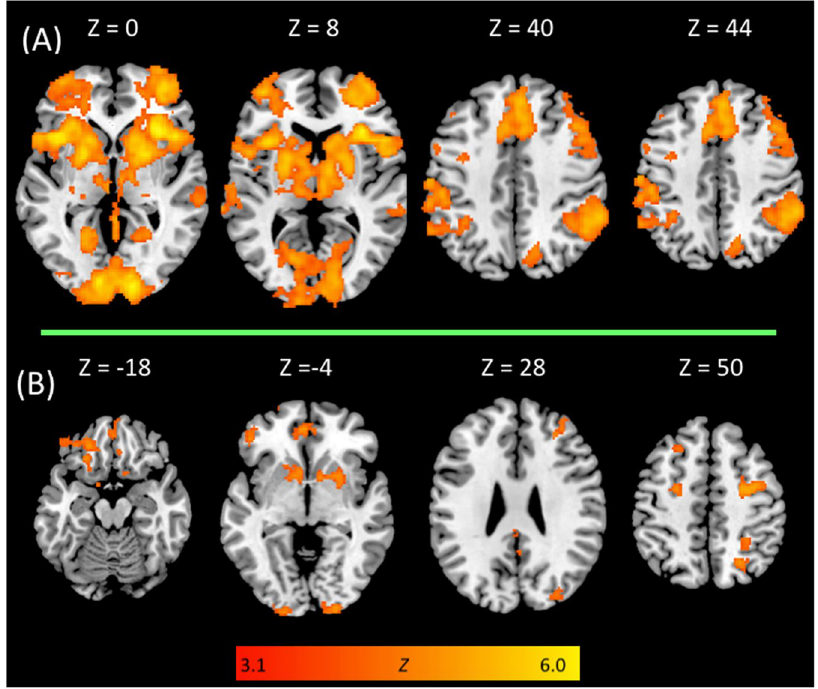
Figure 2. Whole-brain activation within the whole sample of control and poker player ( N = 28) during ( A) proactive motor response inhibition and ( B) reactive motor response inhibition. All contrast maps were thresholded using cluster detection statistics, with a height threshold of z > 3.1 and a cluster probability of p < 0.05, family-wise error corrected for multiple